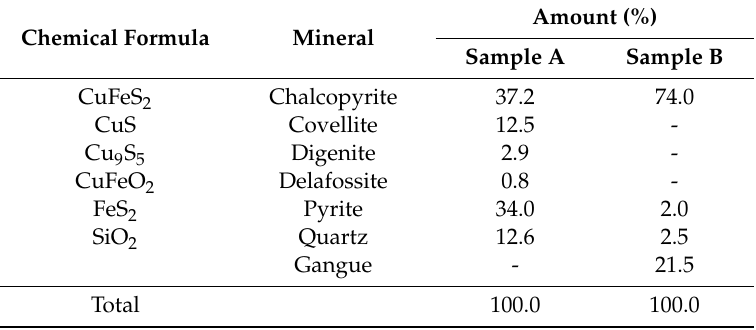
Table 1. Mineralogical composition of concentrate samples. Chemical